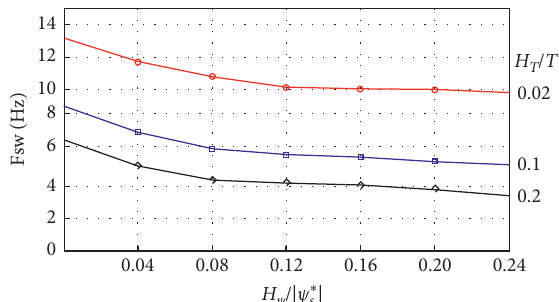
Figure 14: Average inverter switching frequency as function of the ) and torque ( H T ) hysteresis bands. flux ( H ψ